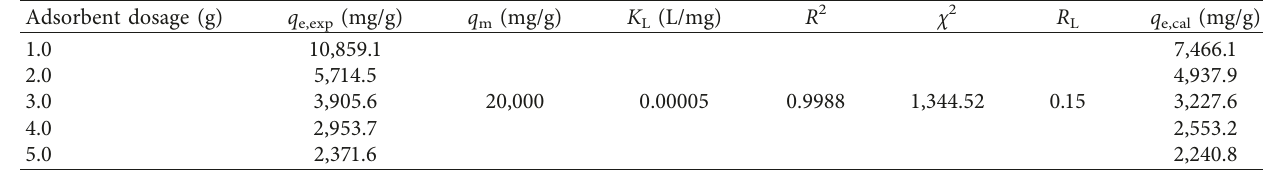
Table 1: Langmuir isotherm constants using modified bagasse using a laboratory-scale system.